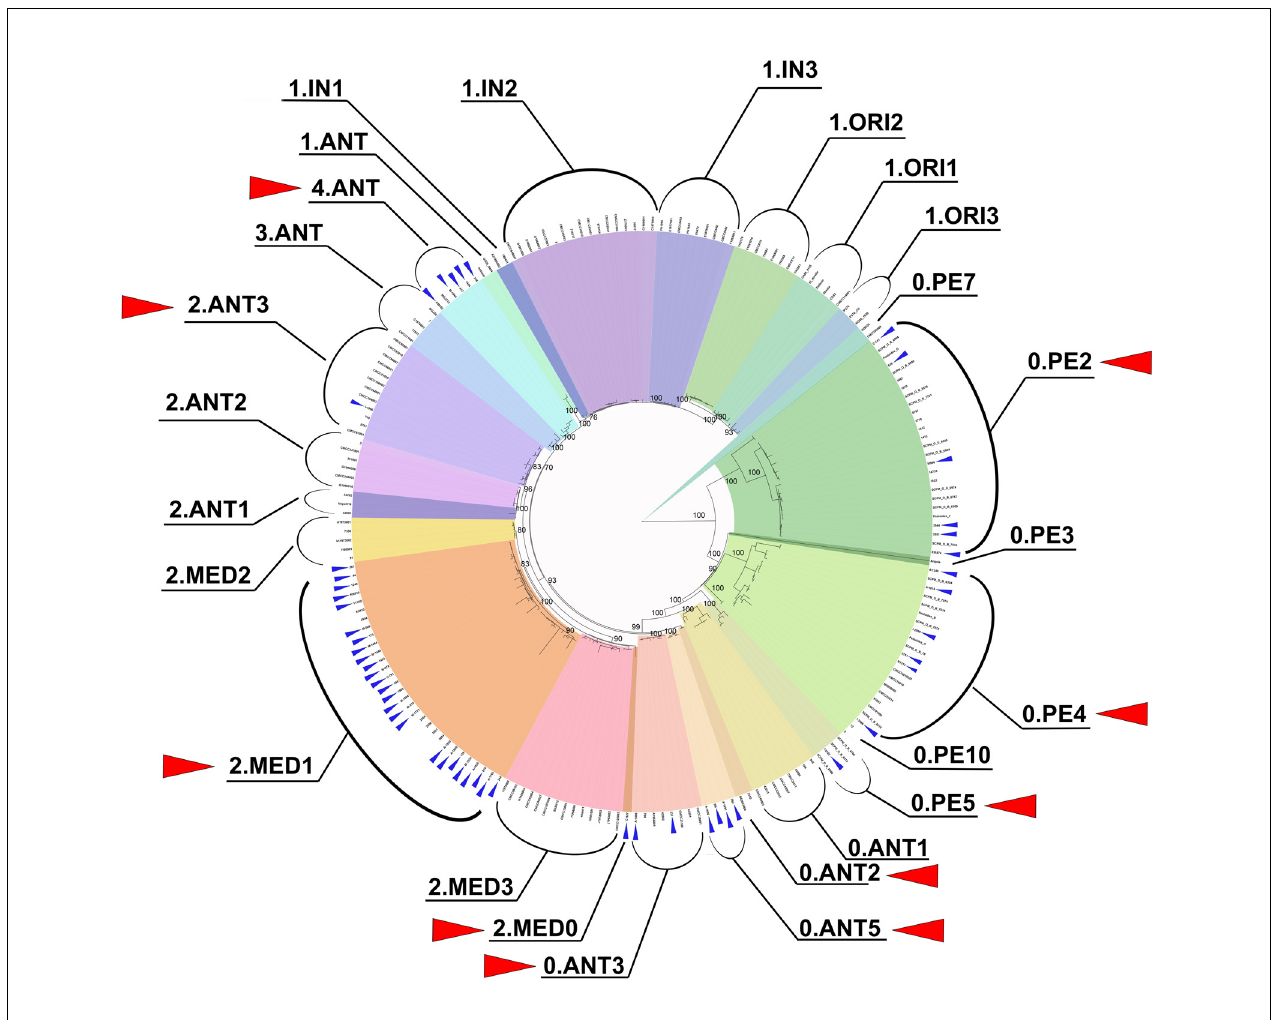
FIGURE 2 | Phylogenetic diversity of Y. pestis strains from CIS plague foci, revealed by core genome SNP analysis. Red triangles mark phylogenetic branches, the strains of which circulate in the plague foci of the CIS countries. Small blue triangles mark strains, sequenced by us. Maximum likelihood tree of 207 Y. pestis genomes, based on 1708 SNPs, is constructed using PHYML 3.1 with the HKY85 model and 500 bootstrap replications.